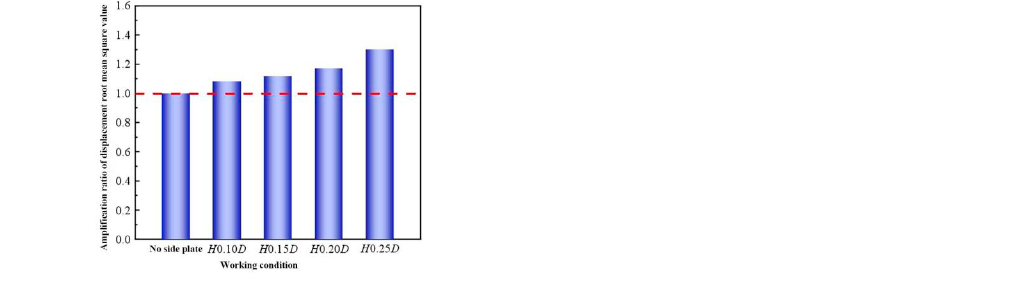
Figure 27. Along-wind displacement response at monitoring point 1 under a windspeed of 12 m/s and different side plate height conditions.